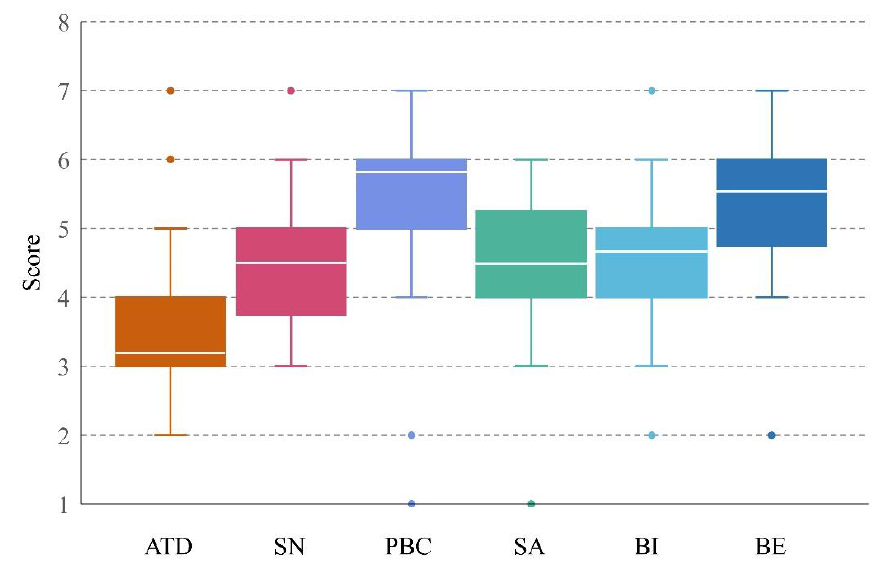
Figure 6. Box whisker plot of the questionnaire samples. Table 4. Correlation coefficients and AVE square roots of latent variables.